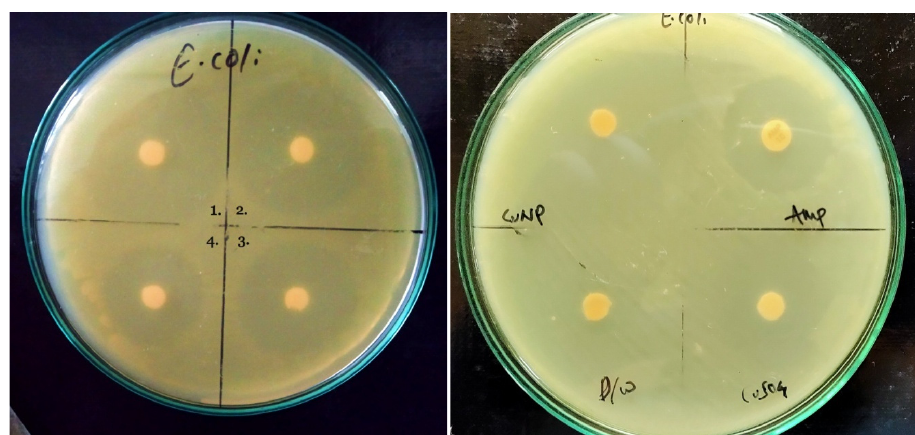
Fig. 12A. & Fig. 12B. Antimicrobial sensitivity of Escherichia